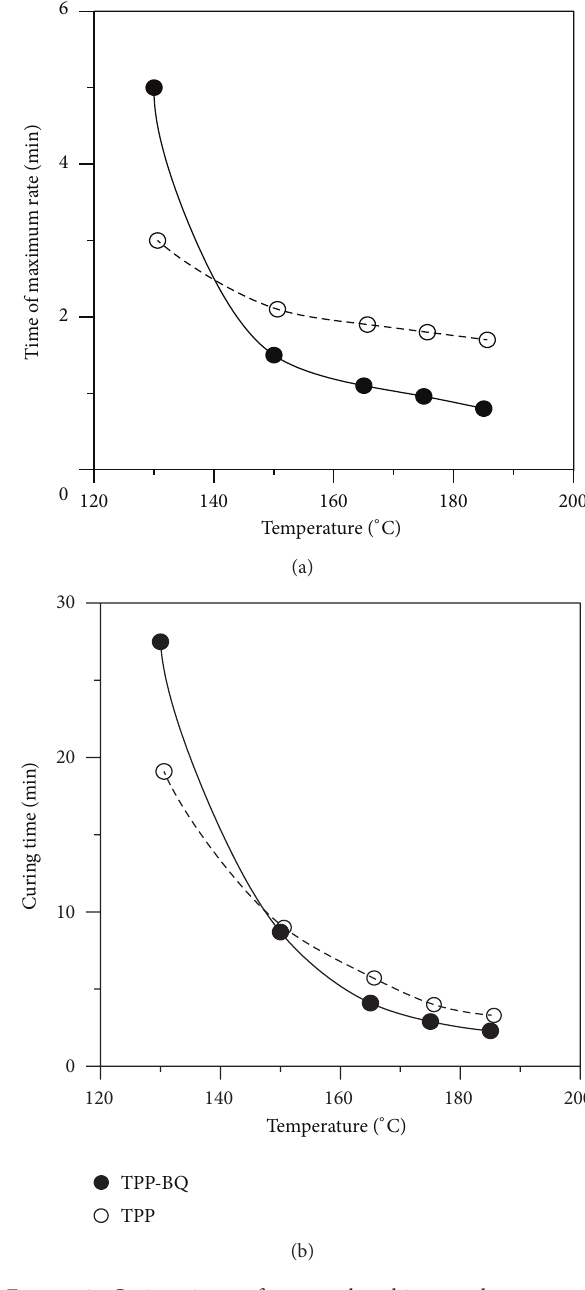
Figure 3: Curing times of organophosphine accelerators-cured EMCs at isothermal temperatures: (a) times of the maximum rate and (b) curing